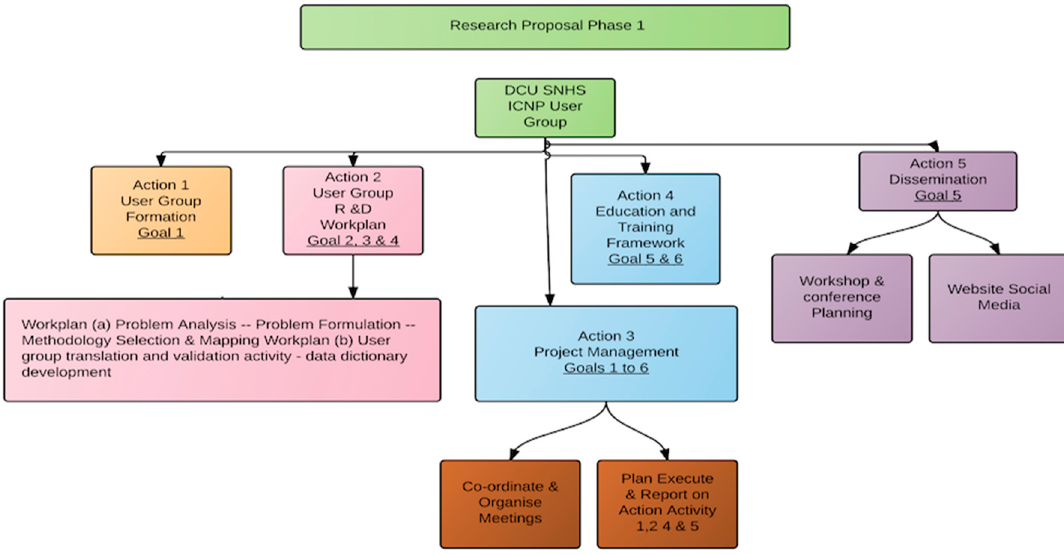
Figure 1. Action Plan Alignment to Centre’s Goals.